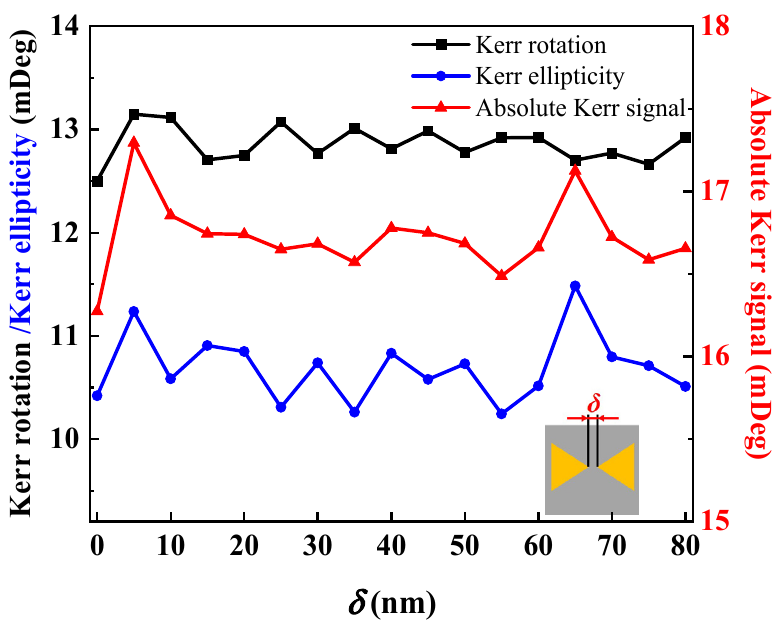
Figure 3. Kerr rotation, Kerr ellipticity, and absolute Kerr signal (the sum of the rotation and ellipticity in quadrature) of PMOKE response for Au bowties of different gap distance δ .